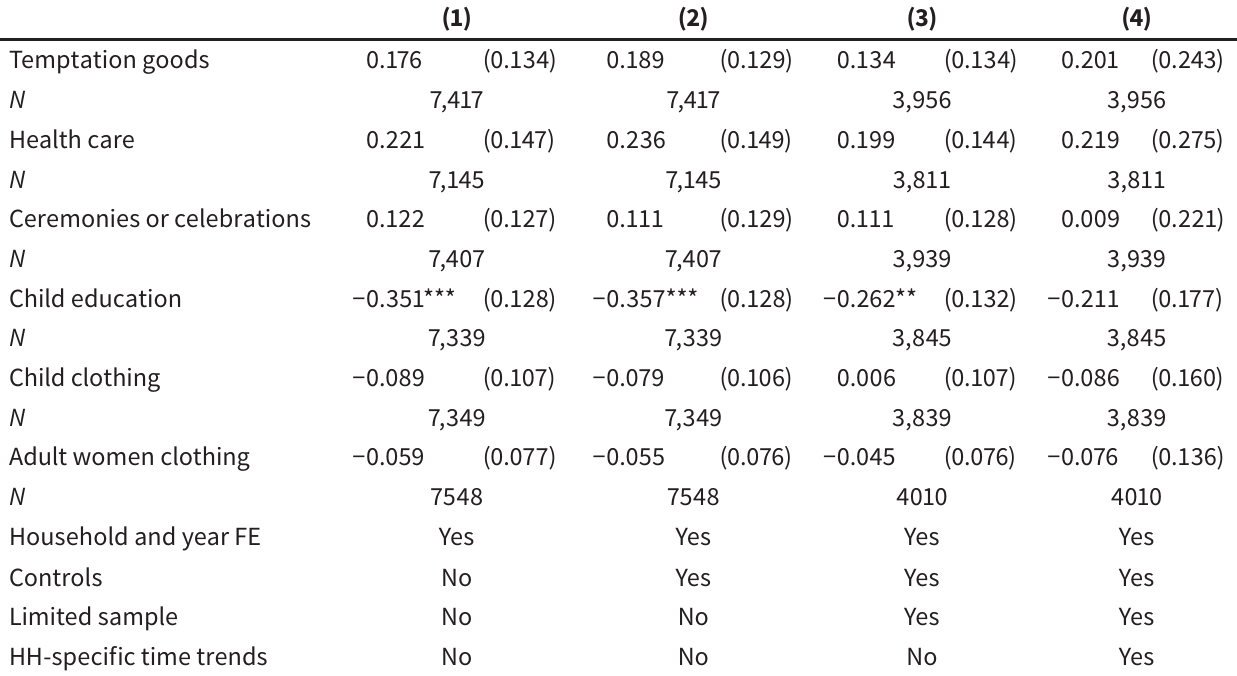
Shifts in expenditures ( asinh ) as son’s migration status